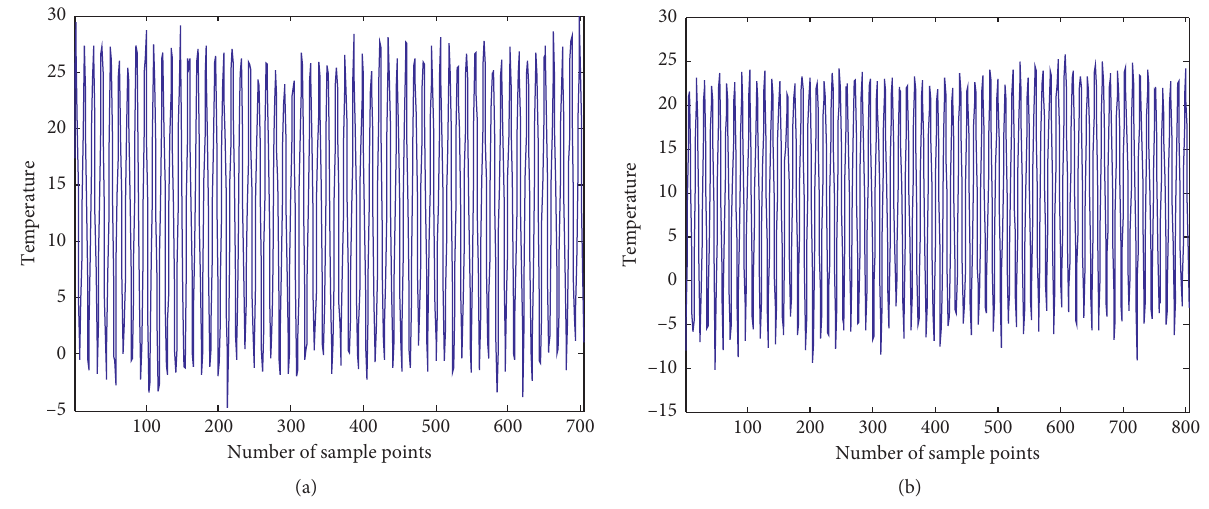
Figure 4: Temperature time series: (a) Xianyang area; (b) Yan’an